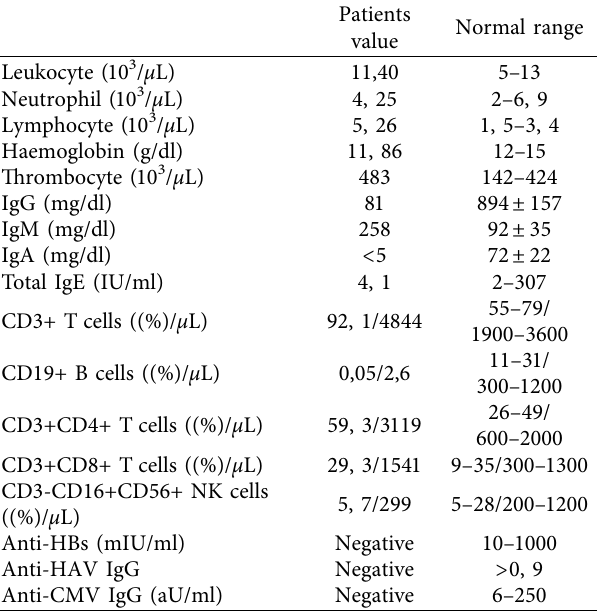
Table 1: Immunologic evaluations at admission and age-related normal